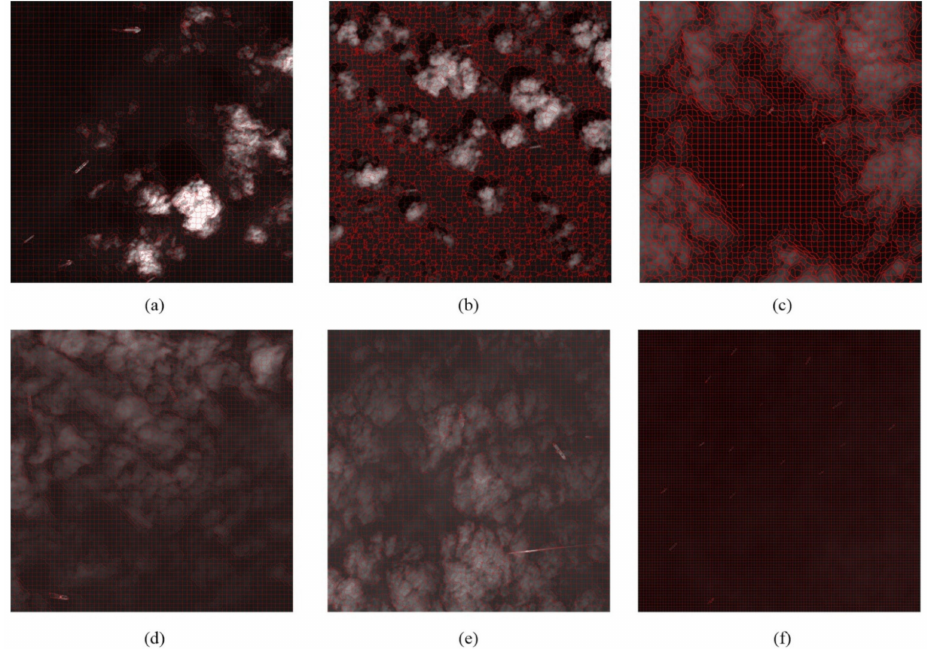
Figure 5. The superpixel segmentation images using the Figure 3 images. ( a – f ) are the superpixel segmentation images using Figure 3a–f. The target area is segmented by superpixels, and some of the targets are segmented into multiple superpixels. The superpixel block is segmented by the red line. We can see that in a uniform background area, the superpixel blocks are square; in areas with targets or disturbed by clouds, the edges of the superpixel blocks are